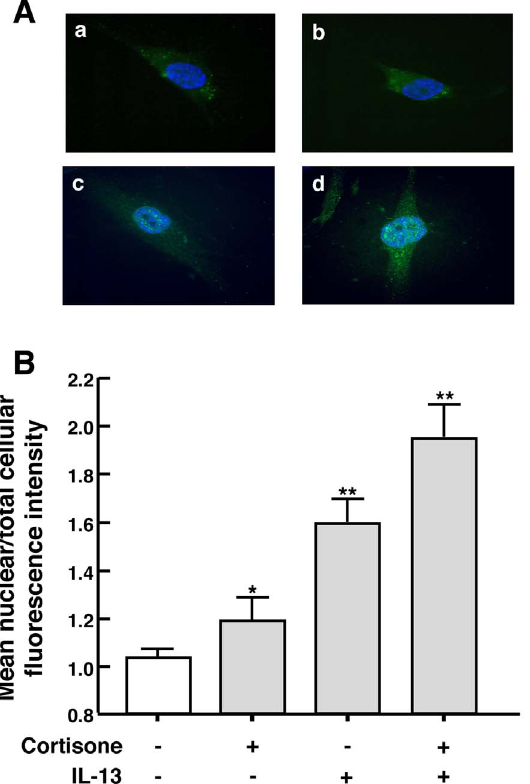
Figure 1. Separate and cooperative effects of DEX-stimulated and unliganded IL-13-induced nuclear translocation of GR in HASM cells. GR localization detected by Immunofluorescence staining (A) and its quantification (B) depicting that, relative to diffuse cytoplasmic distribution of GR in vehicle-exposed (control) HASM cells ( a ), treatment for 30 min with either cortisone ( b ) or IL-13 alone ( c ) elicited increased intra-nuclear localization of GR. which was further enhanced in cells co-treated with cortisone 6 IL-13 ( d ). Note: Induced nuclear translocation of GR by IL-13 alone denotes the presence of ligand-independent GR activation, and heightened GR translocation exhibited by cells treated with cortisone 6 IL-13 demonstrates cooperative effects of ligand (cortisone)-induced and IL-13-induced ligand-independent GR activation. Data represent mean 6 SD values based on an average of 25 HASM cells examined over 3–5 repeats (*p , 0.05; **p , 0.01).